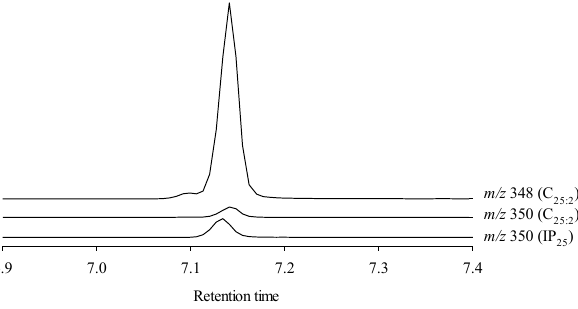
Fig. 4. Partial SIM chromatograms obtained from purified standards of C 25 : 2 and IP 25 . The m/z 348 peak is due to the molecular ion of C 25 : 2 while the smaller contribution from m/z 350 (M + 2 ion) for the same biomarker is shown in the middle chromatogram. The bottom chromatogram ( m/z 350; IP 25 ) illustrates the (partial) chro- matographic overlap between IP 25 and C 25 : 2